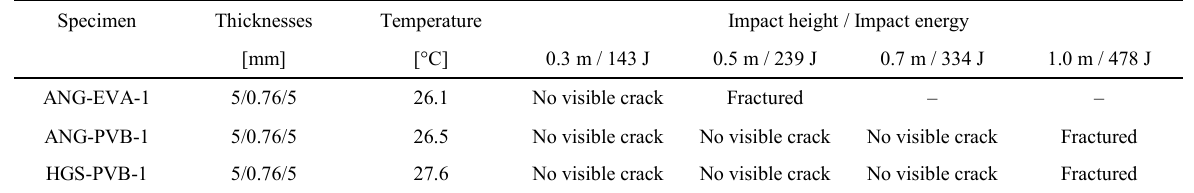
Table 2: Summary of destructive tests on laminated glass